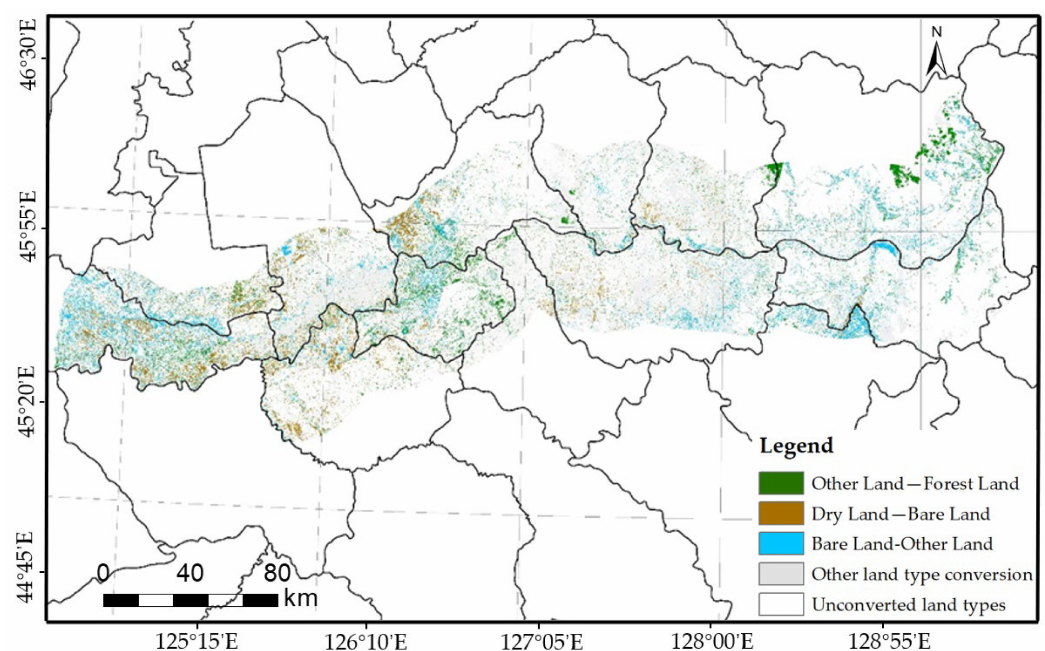
Figure 6. Spatial transfer map of land use types in the buffer zone of the river basin,